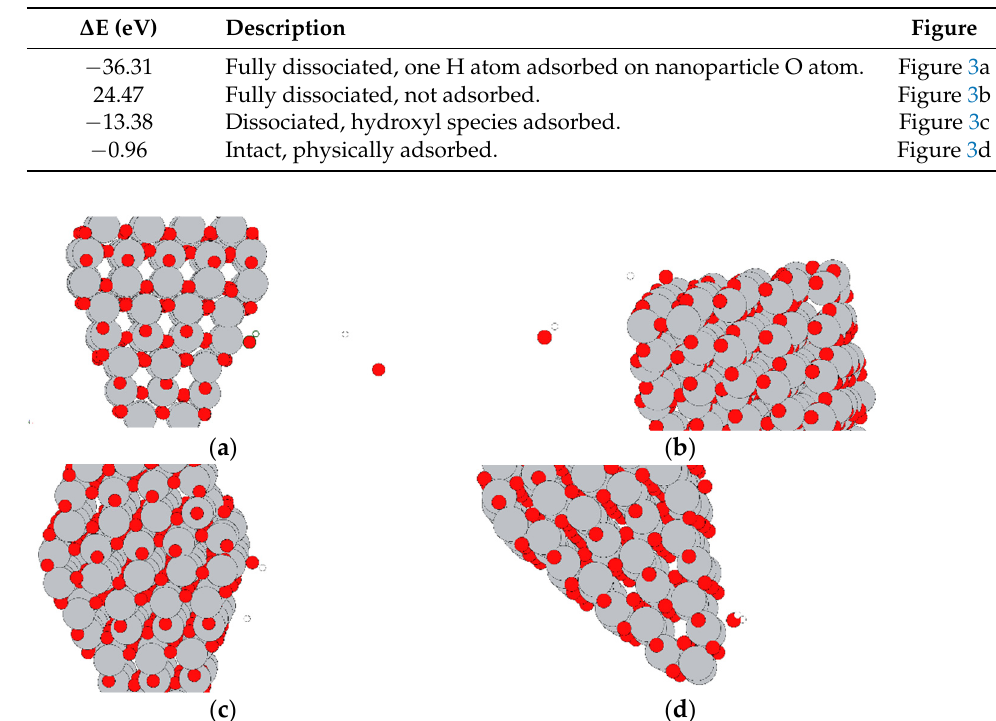
Figure 3. Selected water–nanoparticle interactions. ( a – d ) depict four distinct interactions as described in Table 2.